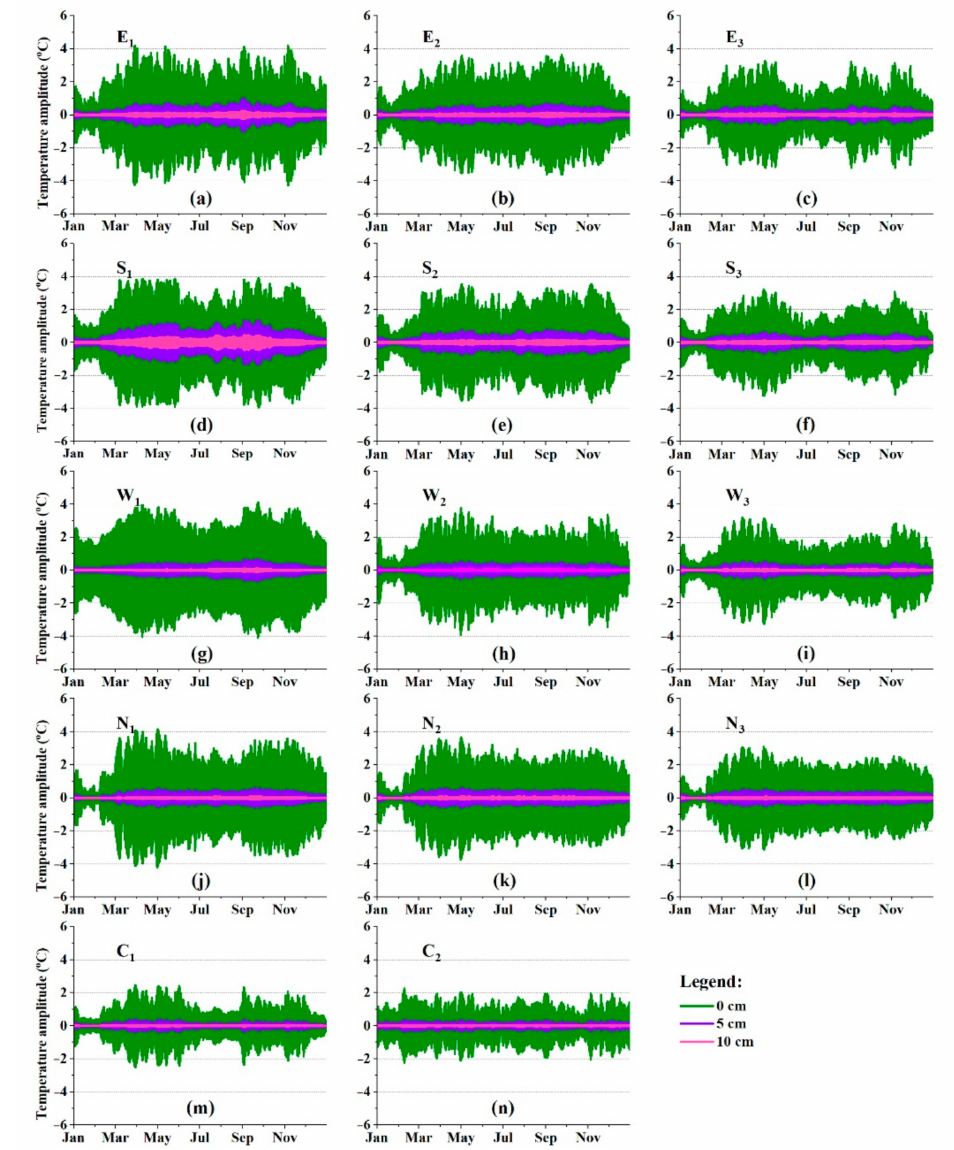
Figure 6. Temporal temperature amplitudes at sediment surface and depths of 5 and 10 cm of the eastern ( a – c ), southern ( d – f ), western ( g – i ), northern ( j – l ), and central sites ( m , n ) at Lake Taihu during 2016. Site locations see Figure